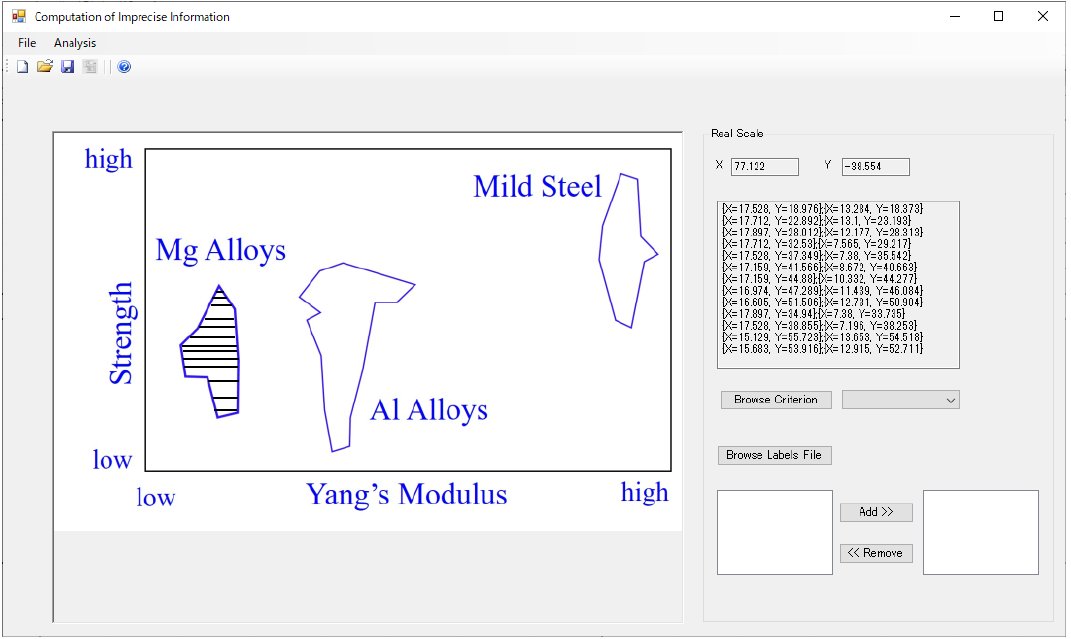
Figure 10. Extracting decision-relevant information from the plot of strength versus Yang’s modulus. Table 3. Decision scores ( D s) of the alternatives with respective to the respective